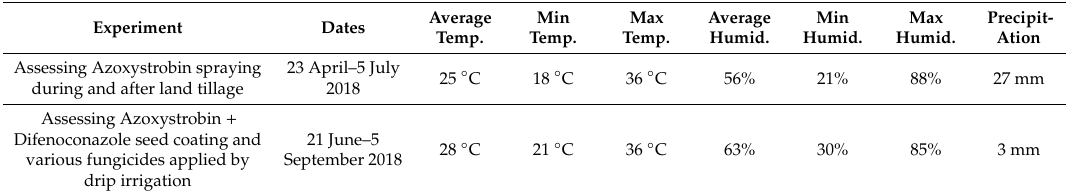
Table 1. Weather conditions in the experimental fields a